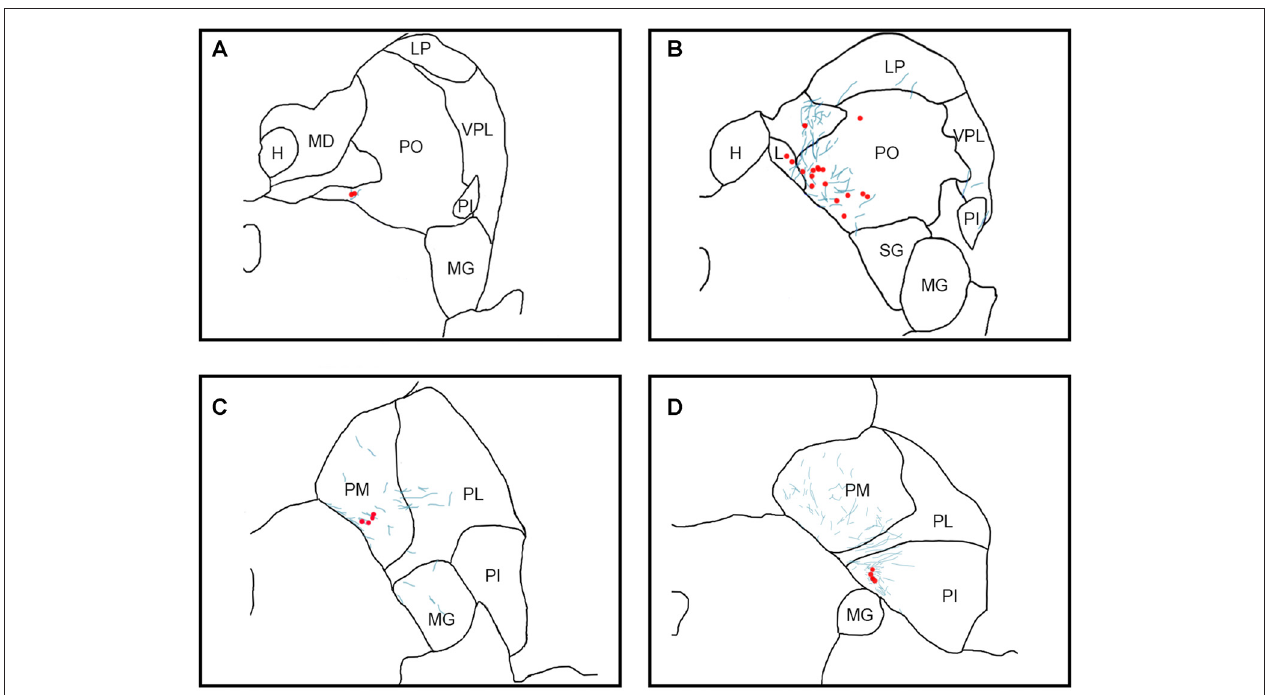
FIGURE 4 | Pattern of overlapping label in Case Y2. Each panel (A–D) presents a plot of labeled cell bodies or fibers from different rostro-caudal levels through the pulvinar. Anterograde label (putative axons) after injection of FE in the SC are shown in cyan. Retrograde label (cell bodies) after injection of CTB in the amygdala are shown in red. Abbreviations for thalamic nuclei are as in Figure 1 .